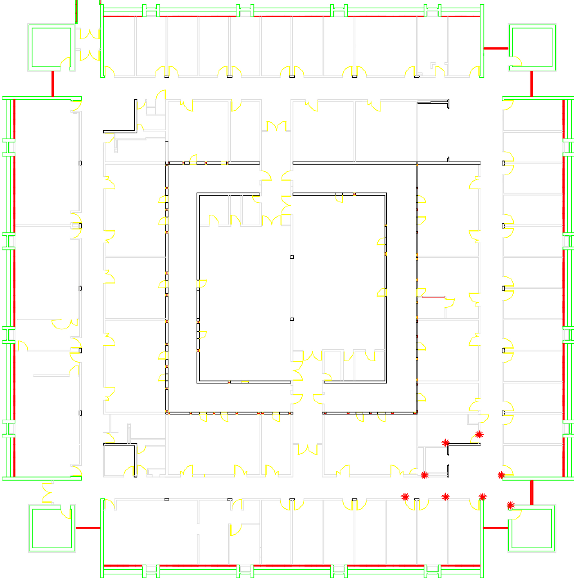
Figure 3. Manually-selected CPs are illustrated using red